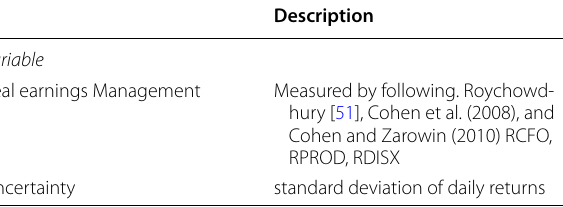
***significance for 0.01,**significance for 0.05, *significance for 0.1. parentheses show standard errors